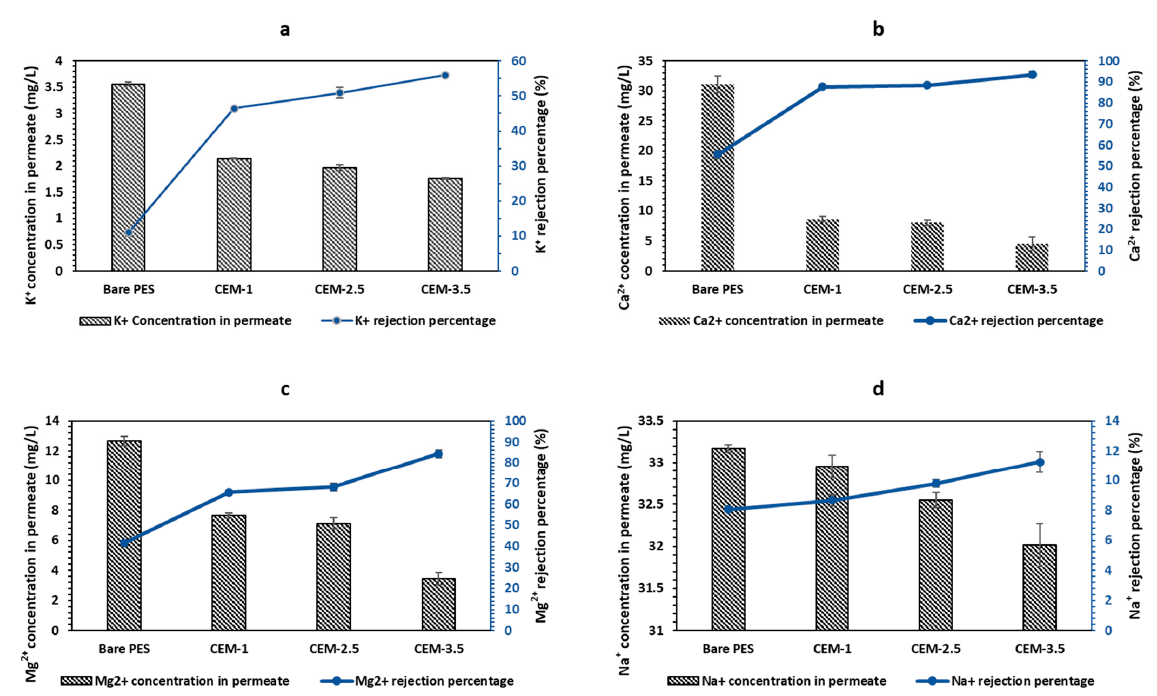
of NO 3 − can be attributed to the use of Amberlite IRA 900 as the source of anion exchange sites that are nitrate-selective [64]. The order of affinity for Amberlite IRA 900 has been reported as NO 3- > SO 42 − > Cl − > HCO 3 − [65]. As a result, the NO 3 − ion was retained the most, Figure 4. Cation rejection percentage of bare PES and CEMs at 0.5 bars in a dead-end filtration system and concentration value of cation in permeate: ( a ) Na + , ( b ) K + , ( c ) Mg 2+ and ( d ) Ca 2+ . Similarly, rejection of anions by AEMs indicated that the AEM-3.5 membrane had the highest percentage of rejection for anions (Figure 5a–d). As with the CEM, an increase in the number of resin particles within the membrane matrix improved rejection. Bare PES membrane had the lowest rejection values for NO 3 − , SO 42 − and Cl − . The rejection of anions by the bare PES membrane is attributed to physical adhesion and possible electrostatic interactions [63]. AEM-3.5 membrane had the highest rejection rates, with 84.21% rejection of NO 3 − , while SO 42 − , Cl − and HCO 3 − were rejected by 52.36%, 23.71% and 17.83%, respec- tively. Figure 5 also shows the concentration of anion after filtration and AEM-3.5 has reduced HCO 3 − (70, 90 mg/L), Cl − (123, 94 mg/L), NO 3 − (4.88 mg/L) and SO 42 − (87.79 mg/L) to 58.26 ± 0.73, 94.56 ± 2.09, 0.77 ± 0.08 and 41.82 ± 2.56, respectively. The higher rejection